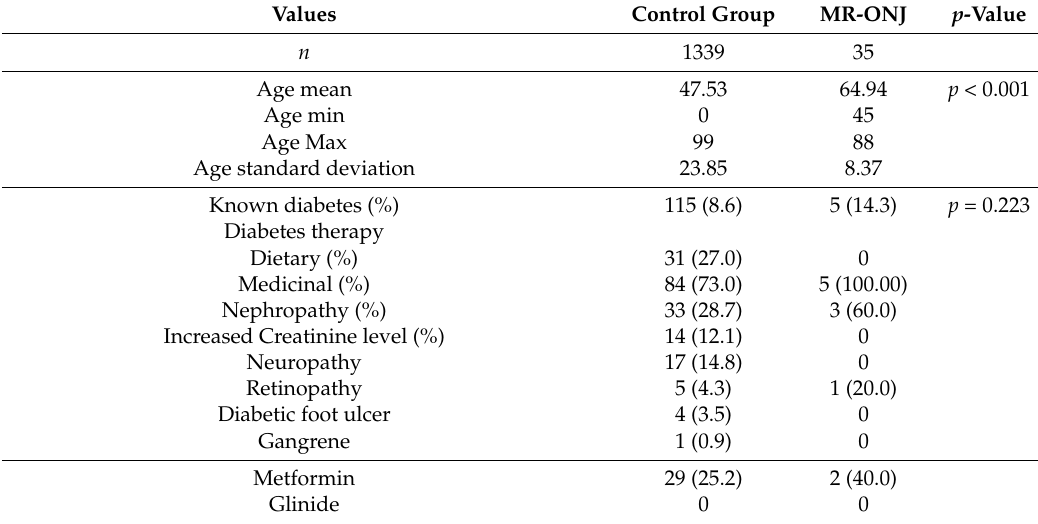
Table 1. Overview of patients with medication-related osteonecrosis of the jaws (MR-ONJ) and the